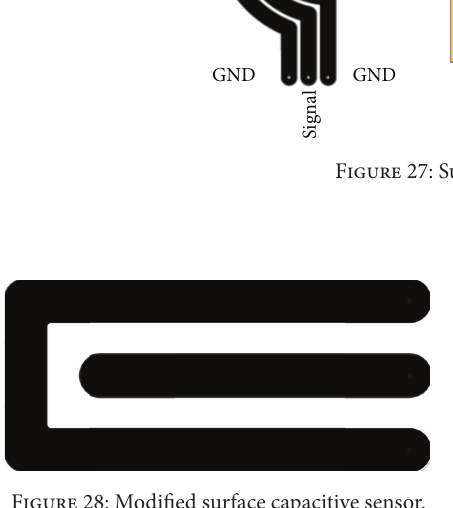
F 28: Modi�ed surface capacitive